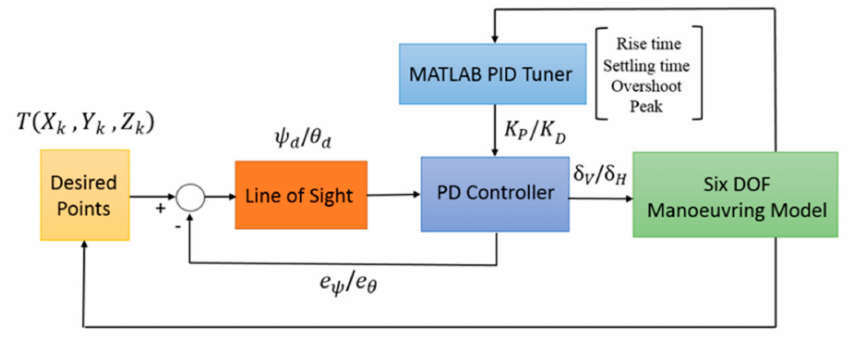
Figure 5. The flow chart of the autopilot system for the submarine free-running model (SFRM) including the LOS guidance algorithm, the PD controller, the PID tuner, and the 6-DOF manoeuvring mathematical